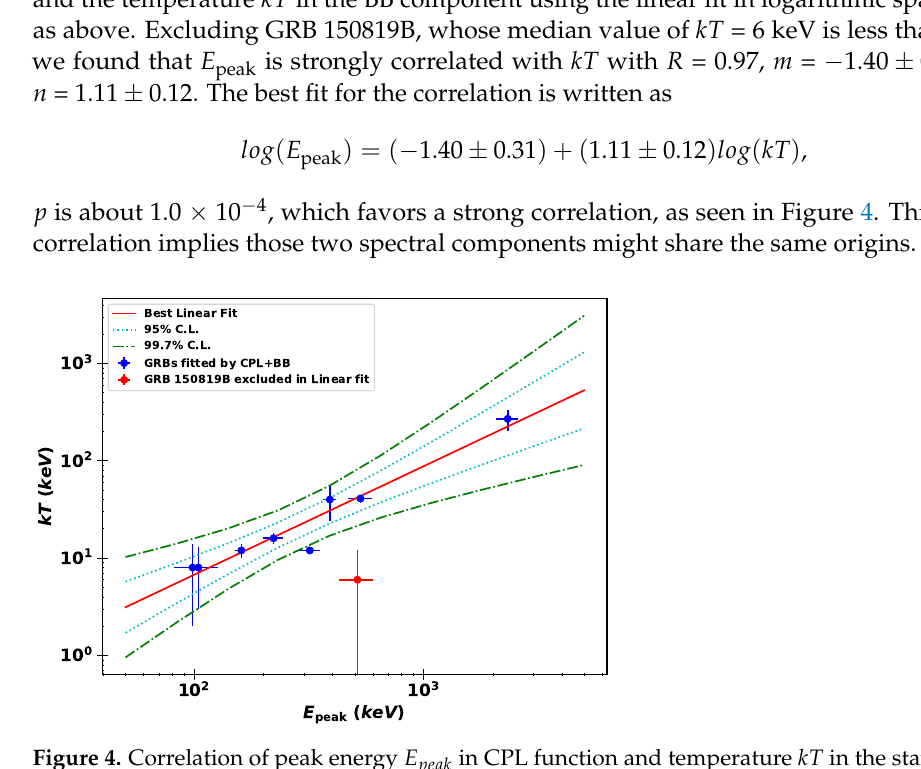
Figure 4. Correlation of peak energy E peak in CPL function and temperature kT in the standard BB function when GRB spectrum is fitted by CPL + BB